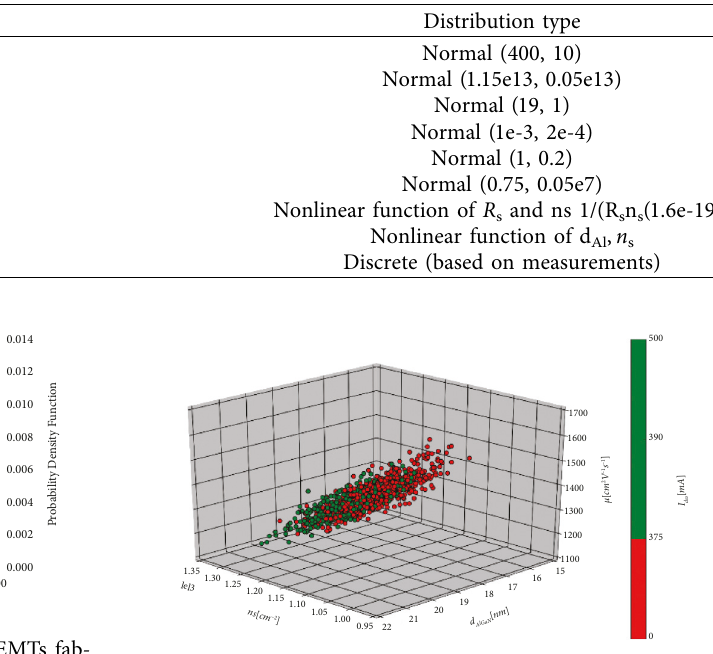
Table 1: The applied model parameters and their distributions are presented.